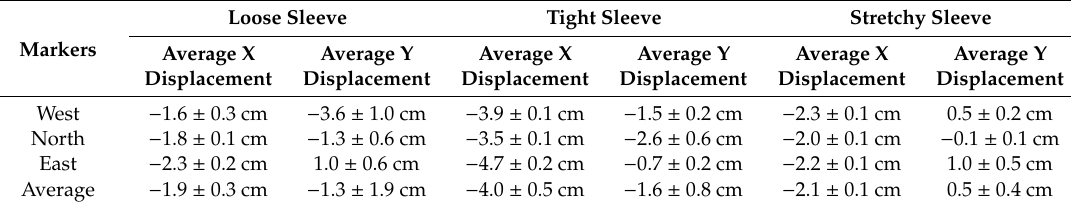
Table 2. Average displacements and standard deviations in the X and Y directions for the three markers on each side, for the loose, tight, and stretchy sleeves, at θ f = 0 ◦ after 10 consecutive flexions. The last row also contains the averages and standard deviations of the data across the West, North, and East sides for